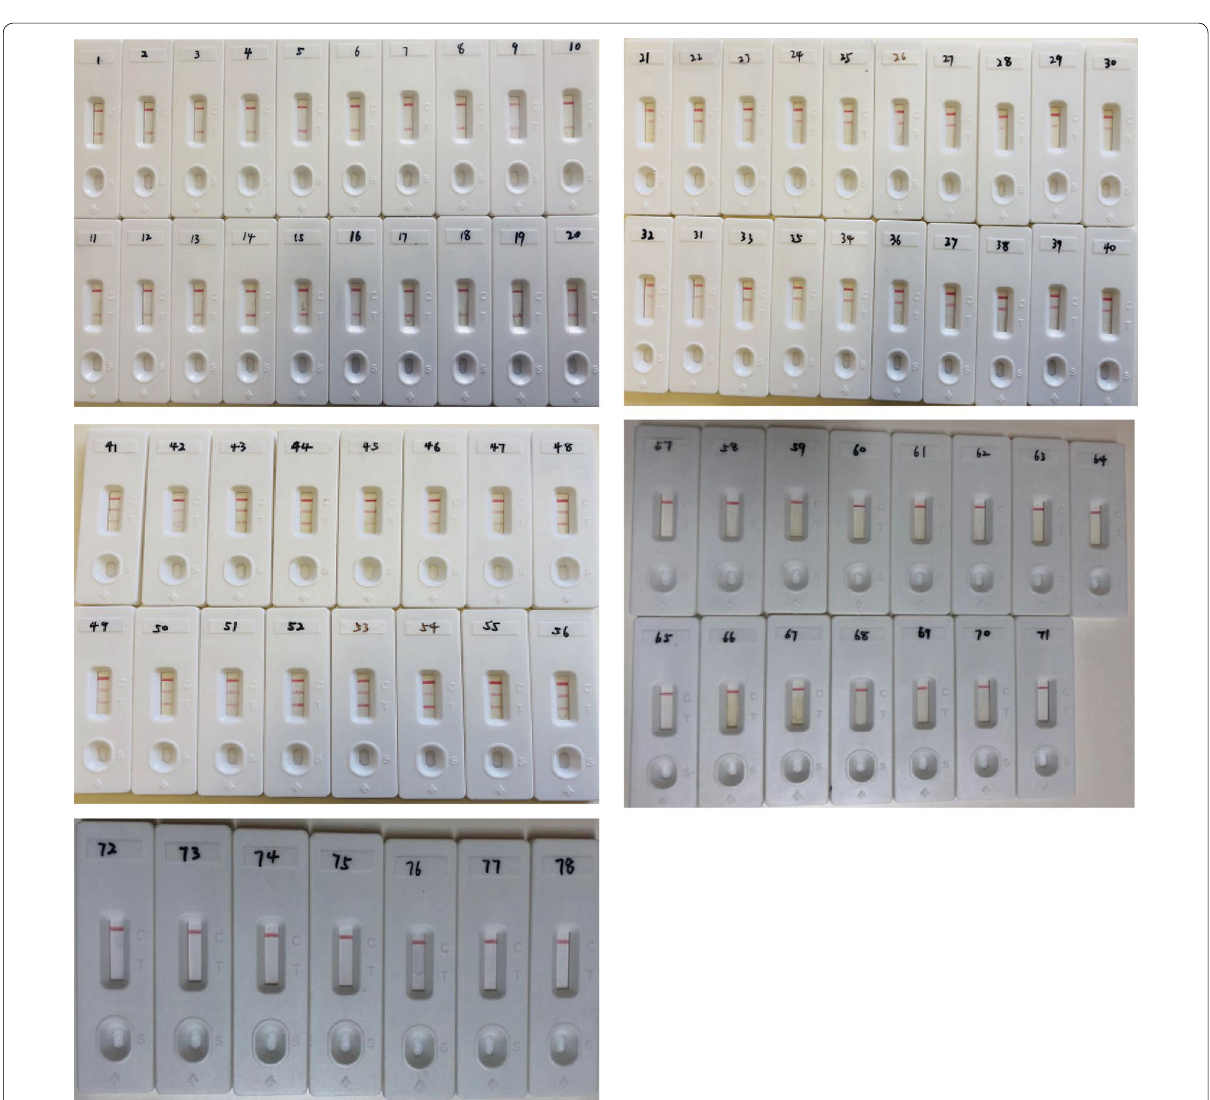
Fig. 5 Feasibility of MABC–LAMP–LFD. 1–20, M. abscessus -DNA; 21–40, M. massiliense -DNA; 41–56, M. abscessus and M. massiliense mixed DNA; 57–71, non- M. abscessus complex isolates DNA; 72–78, non-mycobacterium